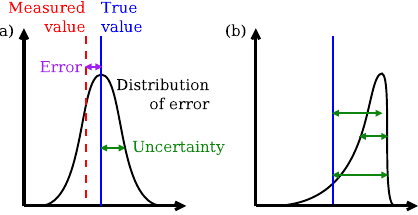
Figure 1. An illustration of error and uncertainty. The error in a measurement (purple arrow) is the difference between the true value of the measurand (solid blue) and the value measured (dashed red). The black line shows the frequency distribution of values that would be obtained if the measurement were infinitely repeated, referred to as the distribution of error. (a) A conventional random error. The uncertainty (green arrow) characterises the distribution of error by its width. (b) An error with a systematic component. This cannot be characterised with a single value.